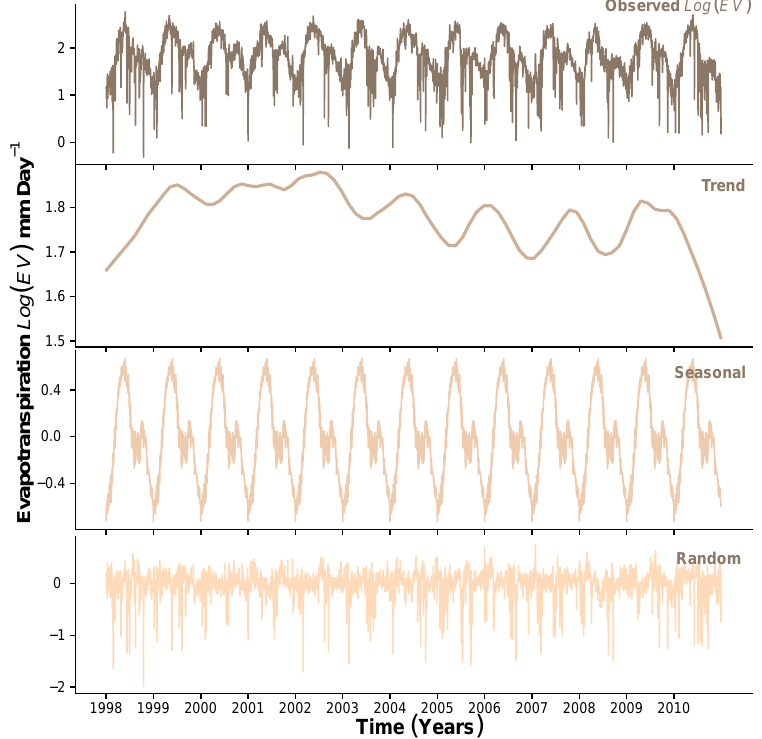
Figure 3. STL decomposition of Log ( EV )